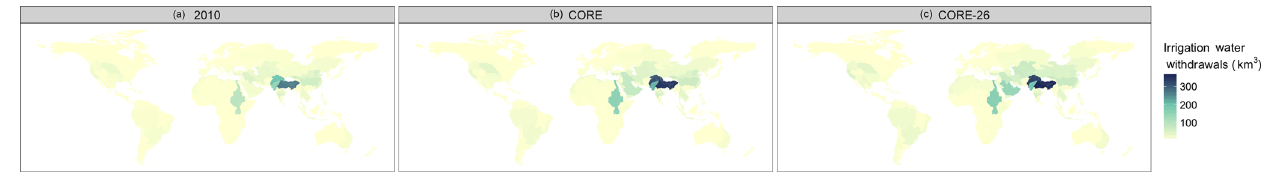
Figure 10. Regional water withdrawals for irrigation in 2010 (a) and 2100 for the CORE (b) and CORE-26 (c) scenarios. Figure shows total irrigation, including both bioenergy and crops.